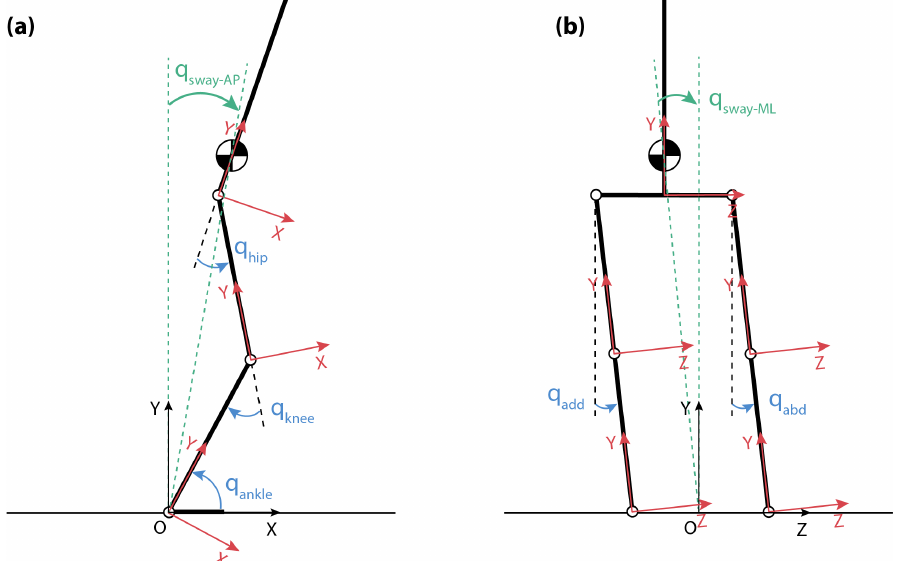
Figure 7. Simplified ( a ) sagittal and ( b ) frontal model used in the calculation of the BenchBalance performance indicators. The convention for joint angles ( q hip , q knee , q ankle , q add / abd , in blue) and sway angle q sway (green) are indicated for both